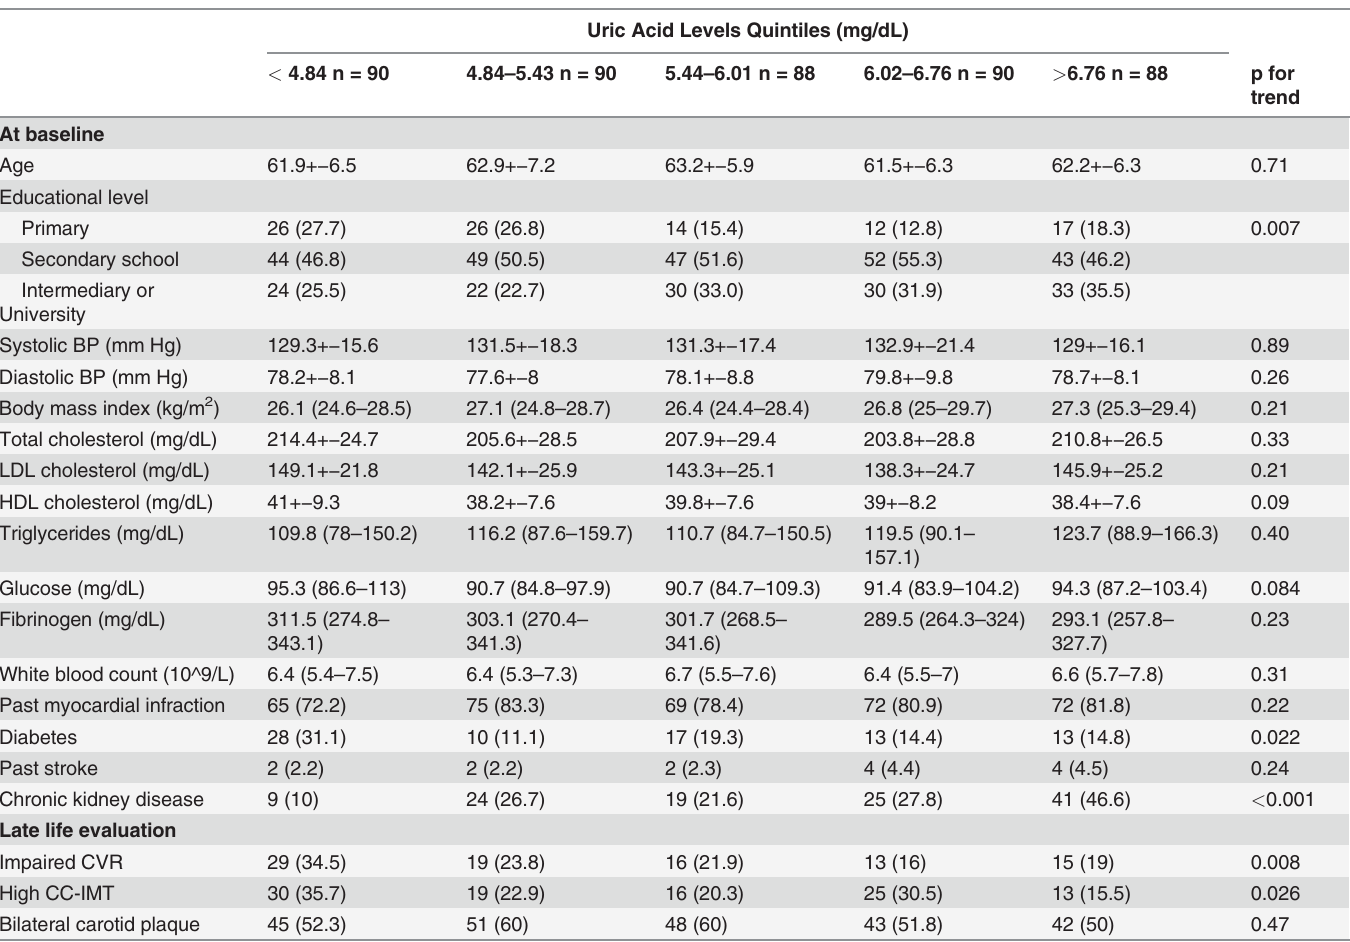
Table 1. Study characteristics according to uric acid